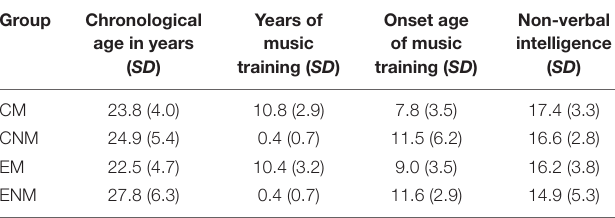
TABLE 1 | Age, years of music training, onset age of music training, and non-verbal intelligence of the Cantonese and English musicians and non-musicians.